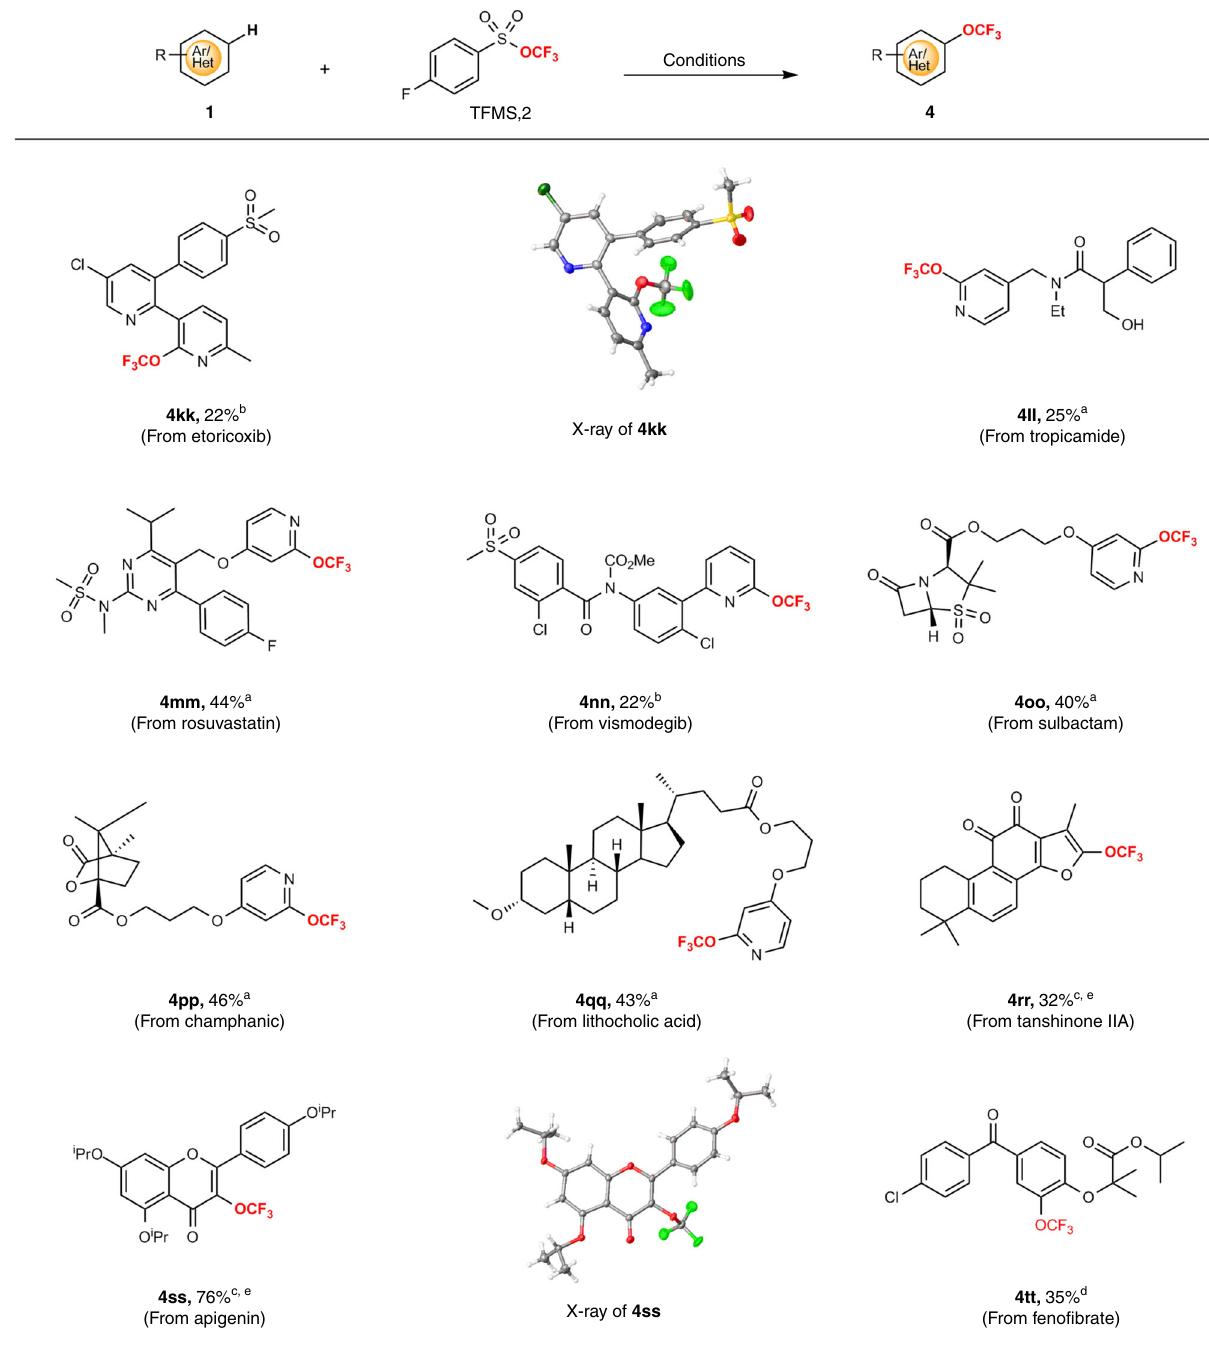
Fig. 3 Late-stage C-H tri fl uoromethoxylation of natural products and drug derivatives. a Method A: 1 (1.0 equiv), AgF 2 (1.0 equiv), TFMS ( 2 ) (3.0 equiv), Select fl uor (2.0 equiv), CsF (3.0 equiv), DMC, N 2 , 35 °C. b Method B: 1 (1.0 equiv), AgF 2 (4.0 equiv), TFMS ( 2 ) (4.0 equiv), MeCN, N 2 , 10 °C. c Method